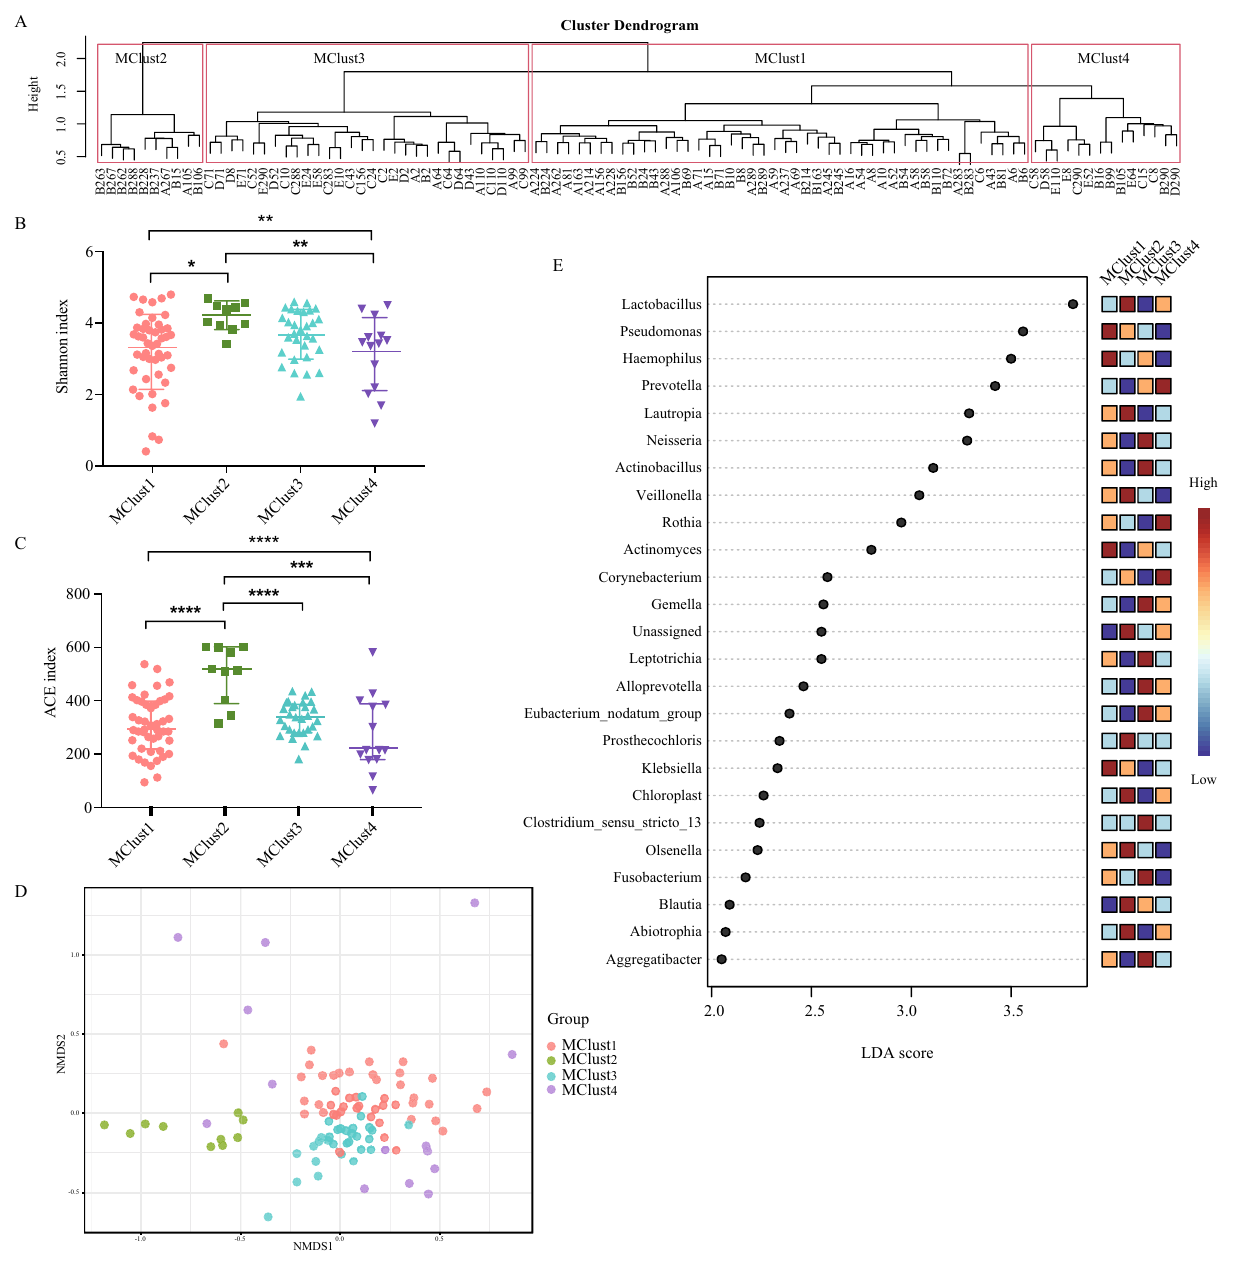
Figure 5. Characteristics of respiratory microbiome in four microbial clusters (MClusters). ( A ) Unsupervised clustering of respiratory microbiome based on Jaccard distance. ( B , C ) The Shannon index and ACE index among the four clusters. ( D ) The NMDS plot based on Bray Curtis distances. ( E ) Histogram of LDA values of LEfSe analysis of respiratory microbiome in clusters ( p < 0.05 by the Wilcoxon test). NMDS non-metric multi- dimensional scaling, LDA linear discriminant analysis, LEfSe linear discriminant analysis effect